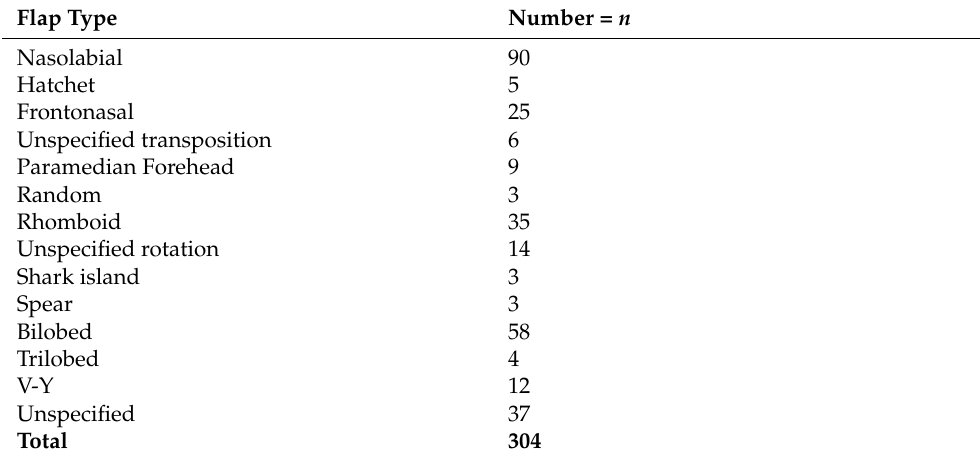
Table 3. Variety of utilized flaps.